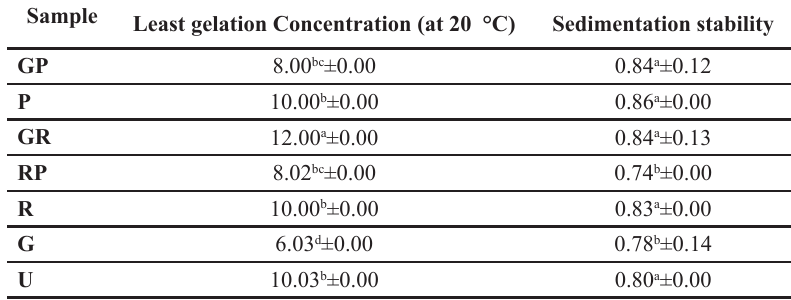
Table 3: Least gelation concentration and sedimentation stability of yoghurt from pre-treated Bambara groundnut.